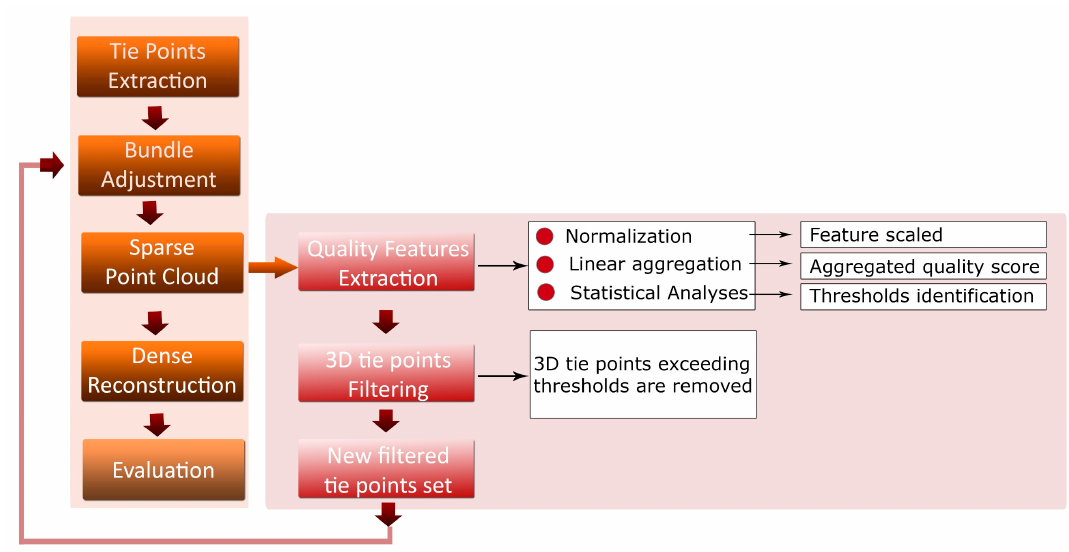
Figure 1. The flowchart of the proposed pipeline. The standard photogrammetric workflow (left block) is enriched with the filtering procedure developed in Python (right block).